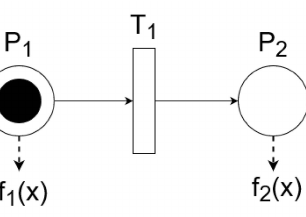
Figure 3. Basic elements of a signal-interpreted Petri net. P: place; T: transition; f(x): output functions.